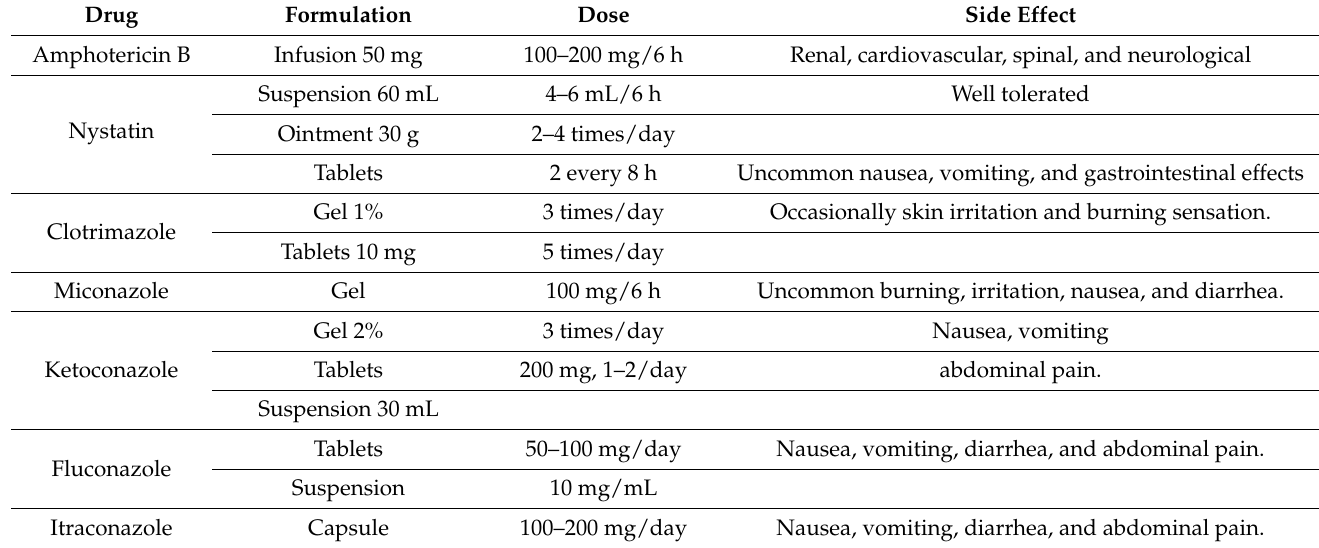
Table was adapted with permission of CEDRO, Centro Espanol de Derechos Reprograficos, from “Current treatment of oral candidiasis: A literature review”, 6, 5, 2014 [98]); permission conveyed through Copyright Clearance Center, Inc. (Danvers, MA,